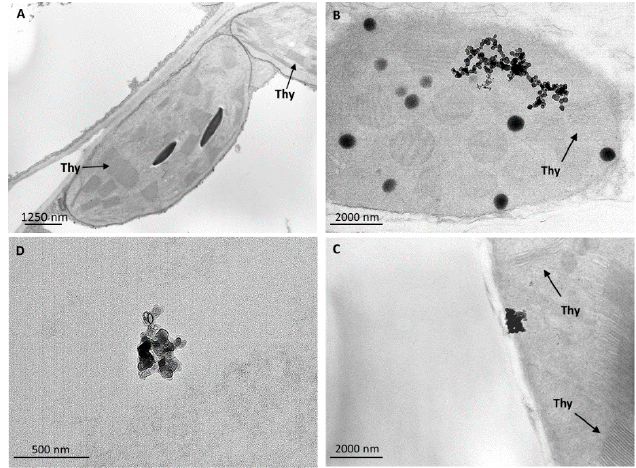
Figure 3. Representative TEM micrographs of leaf tissues from barley plants. In control untreated leaf